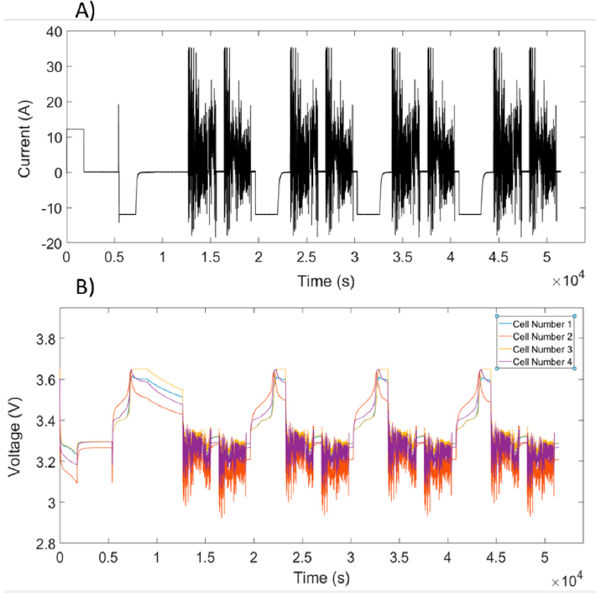
Figure 5. The validation current profile ( A ) and the corresponding voltage response ( B ) for the LFP battery pack at a constant temperature of 20 °C. battery pack at a constant temperature of 20 ◦